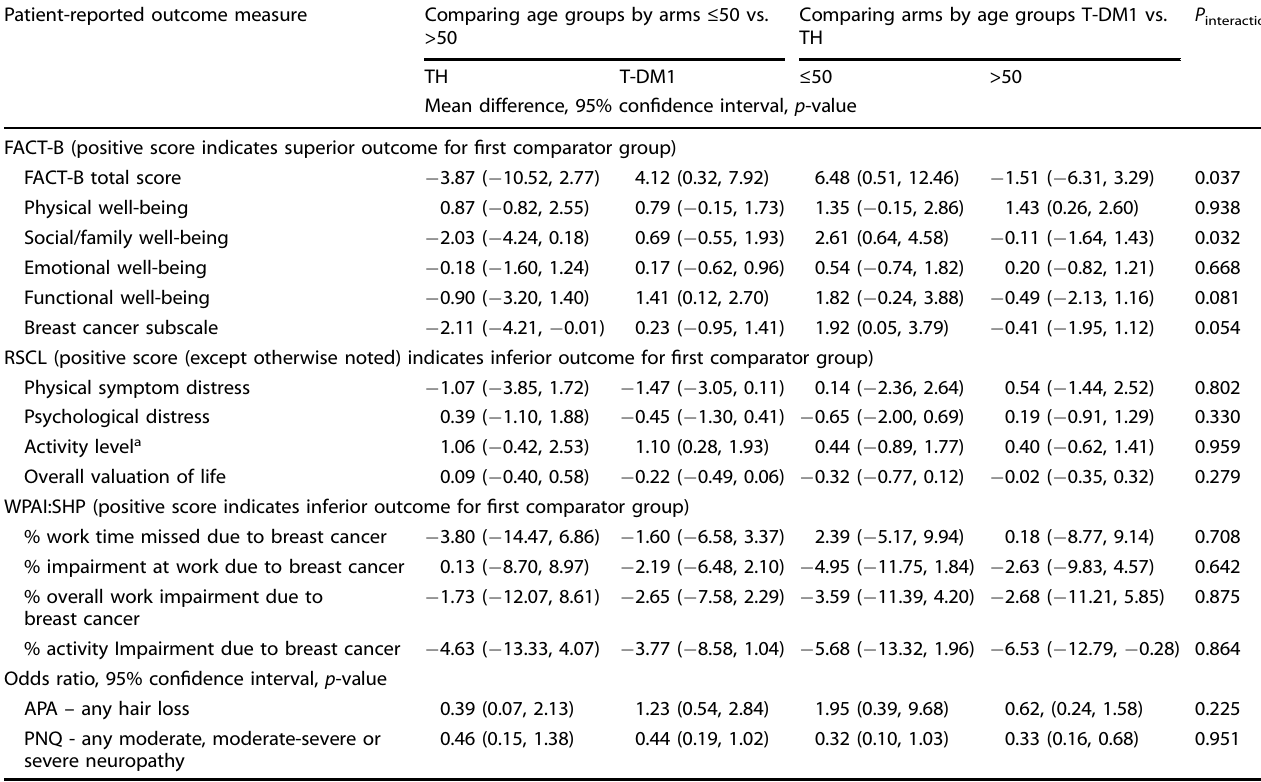
T-DM1 trastuzumab emtansine, TH paclitaxel plus trastuzumab, FACT-B Functional Assessment of Cancer Therapy-Breast Cancer, RSCL Rotterdam Symptom Checklist, WPAI:SHP Work Productivity and Activity Impairment Questionnaire: Speci fi c Health Problem, APA Alopecia Patient Assessment, PNQ